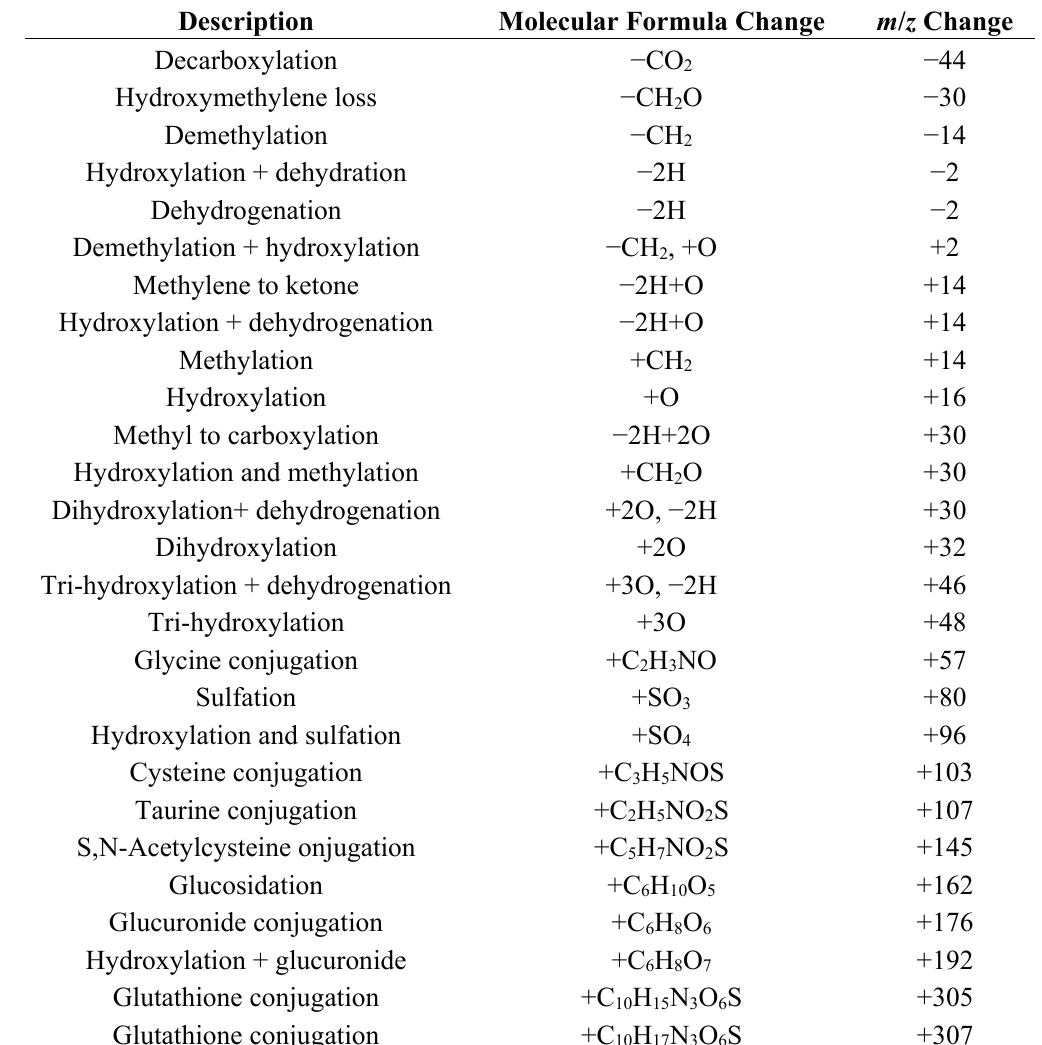
Table 3. Presupposed metabolic types and the m / z changes for potential metabolites of AA and